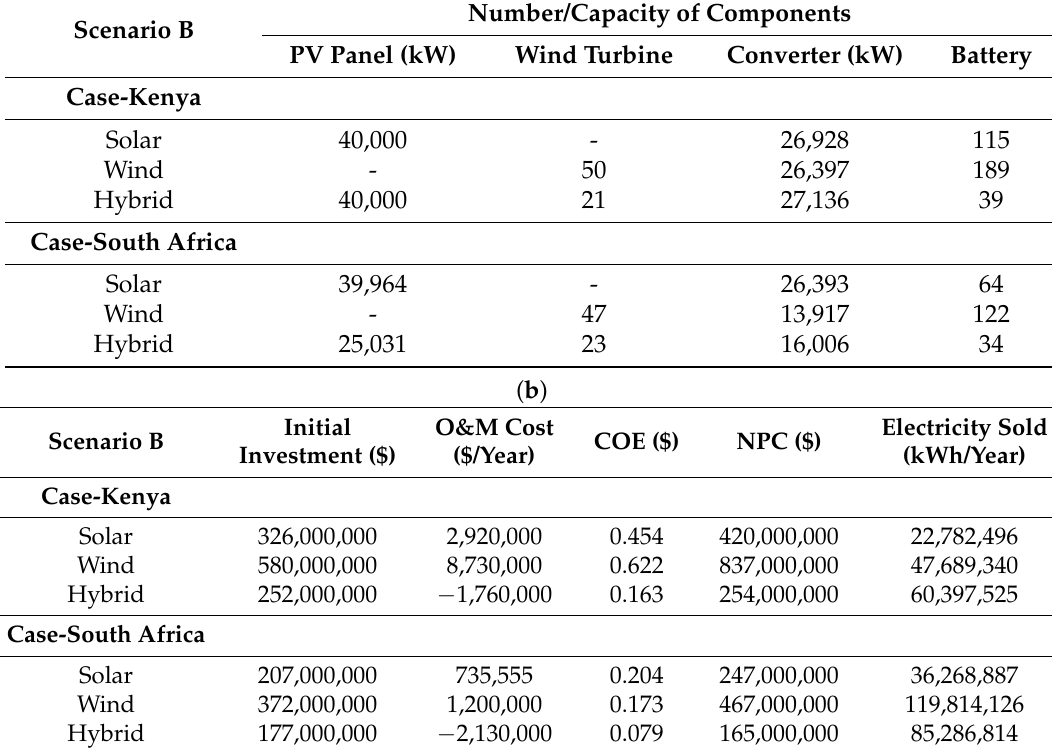
Table 4. ( a ) Optimized configurations of the examined renewable power systems for scenario B; ( b ) Economic results of optimized configurations of the examined renewable power systems for scenario